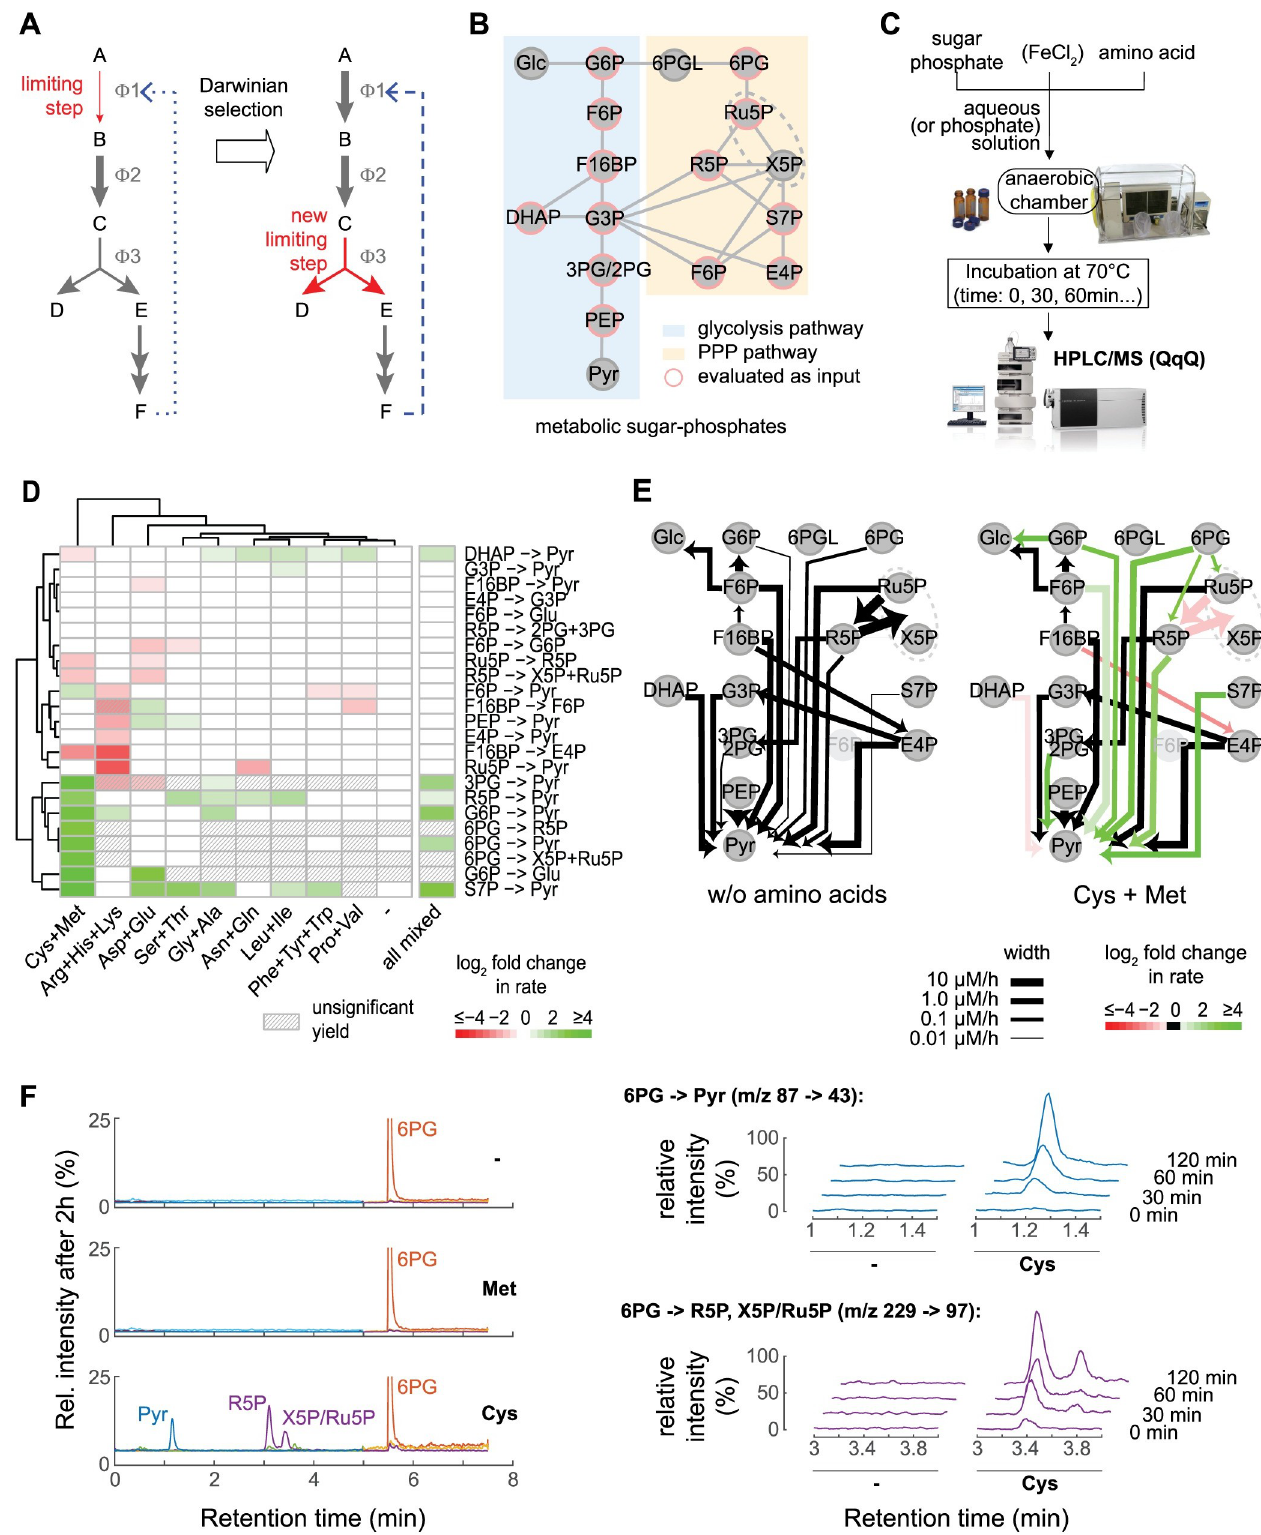
Fig 1. Multiple amino acids, in particular cysteine, accelerate or slow nonenzymatic interconversions between glycolytic and PPP sugar phosphates. (A) Hypothesis of early metabolic pathway evolution through stepwise enzymatization of a nonenzymatic chemical network. Selective pressure to increase the